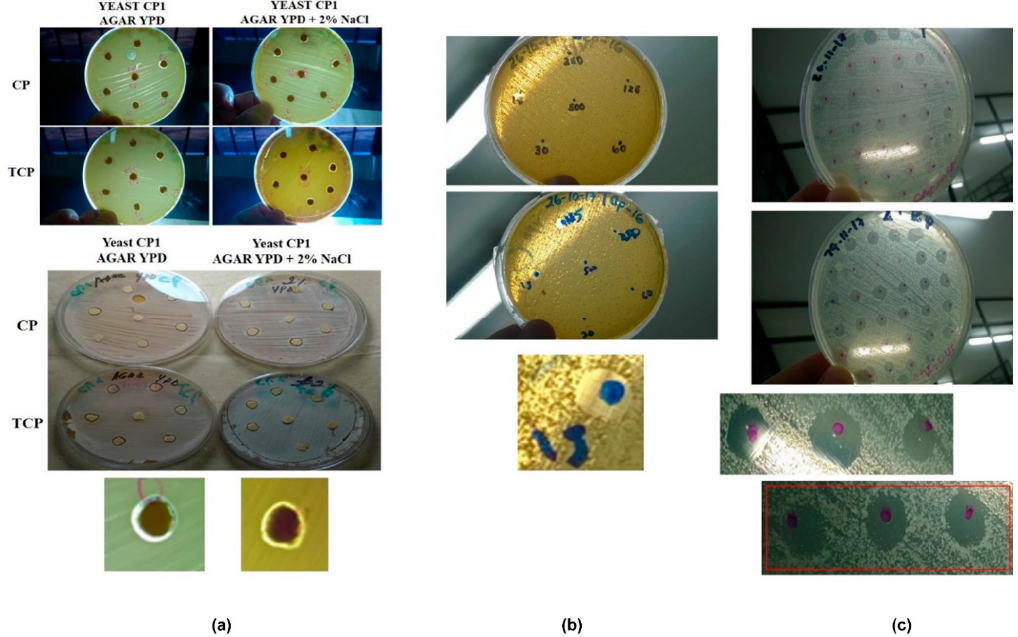
Figure 3. Inhibition of yeasts on agar surface. ( a ) Pilot test 1. Test of the use of sensidiscs on agar with concentrations of substance. ( b ) Pilot test 2. Substance concentration test directly on agar. ( c ) Definitive test for MIC. Determination with substance concentrations on agar.